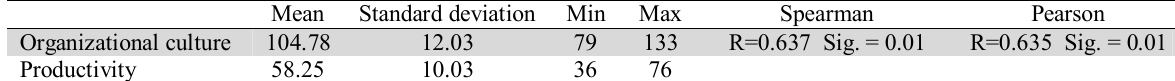
Organizational culture